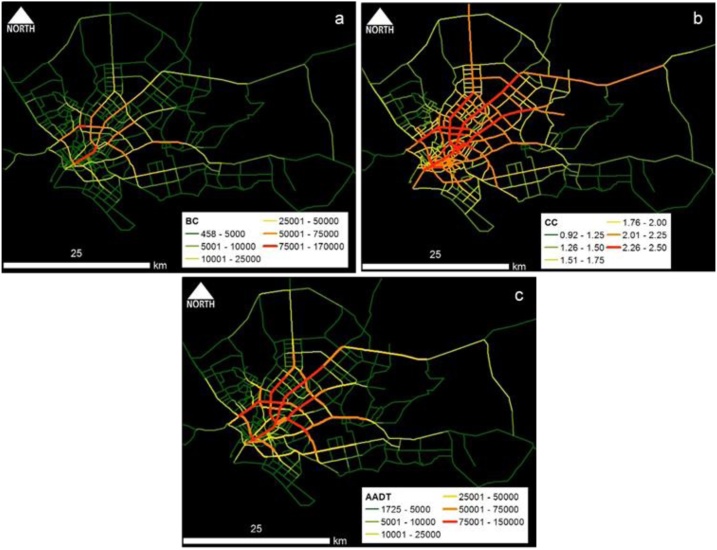
Karachi case study area: Spatial distribution of (a) BC(PD) and (b) CC(PD) and (c) estimated AADT.